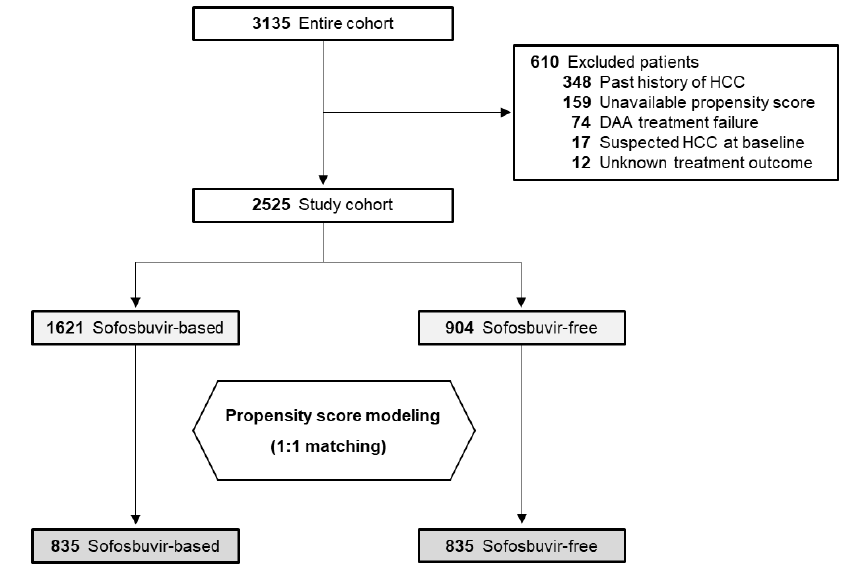
Figure 1. Study flowchart. HCC, hepatocellular carcinoma; DAA, direct-acting antiviral. Table 1. Baseline characteristics after propensity score